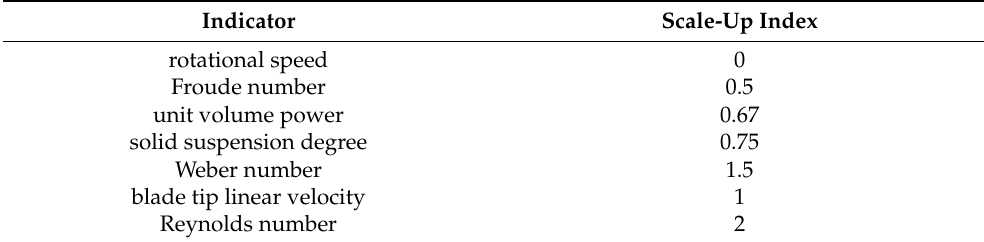
Table 1. Scale-up indicators of mixing